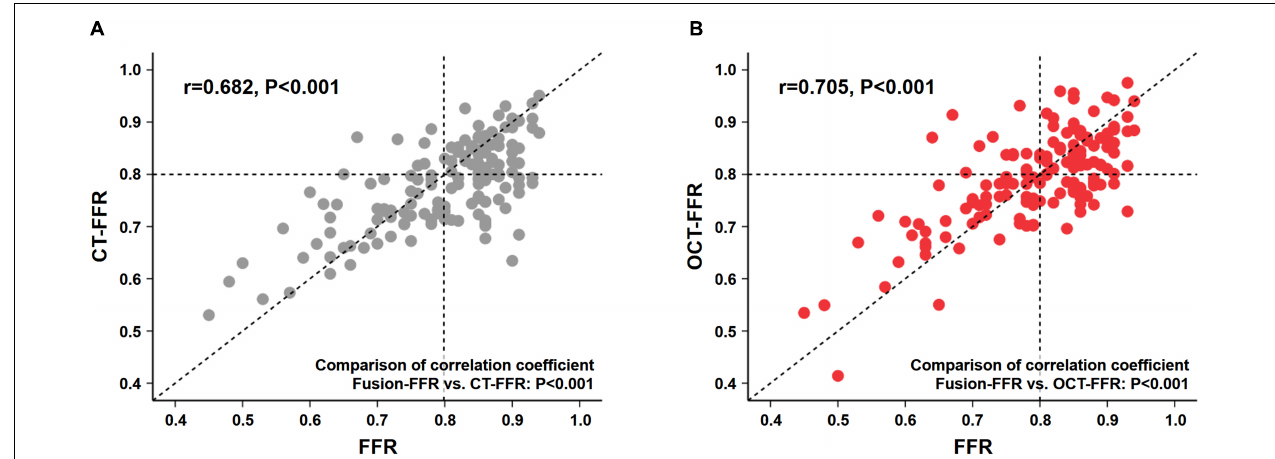
FIGURE 3 | Correlation between pressure wire-based FFR and CFD-based computational FFR from coronary CTA or OCT images. Correlation between pressure wire-based FFR and CT-FFR (A) , and between FFR and OCT-FFR (B) . CFD, computational fluid dynamics; CTA, computed tomography angiography; CT-FFR, computational FFR from coronary CTA; FFR, fractional flow reserve; OCT, optical coherence tomography; OCT-FFR, computational FFR from OCT.